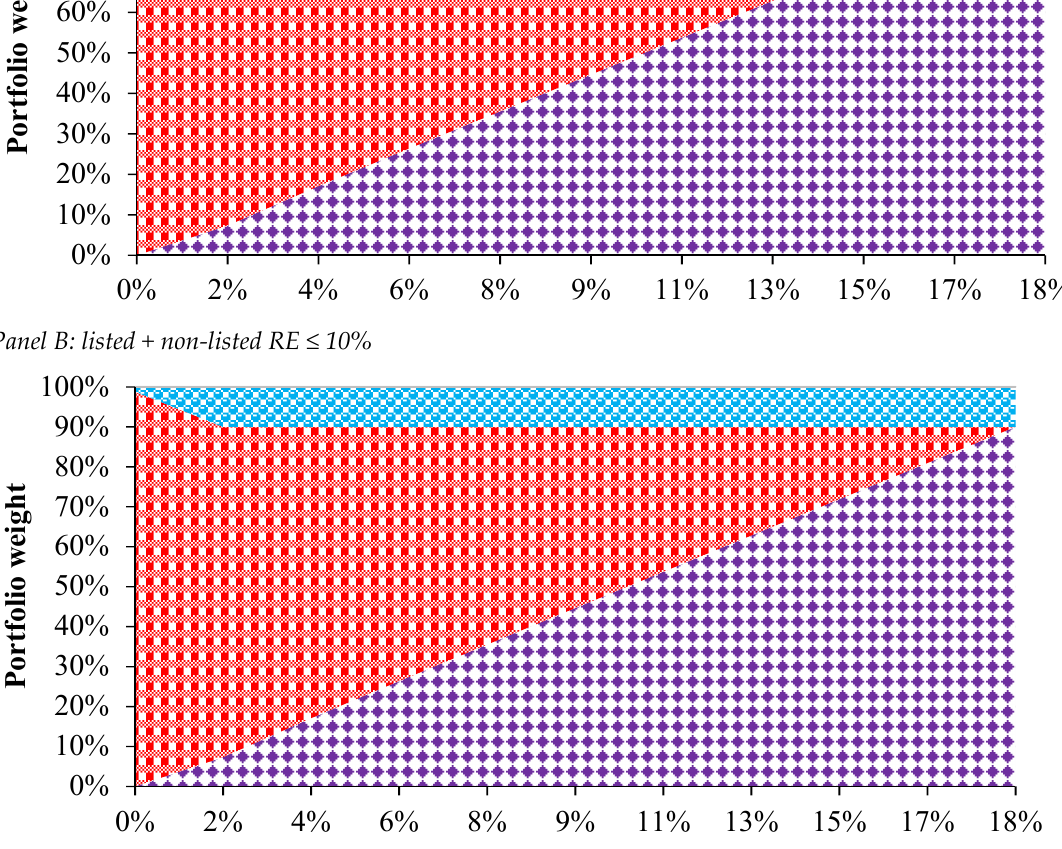
Figure 1. Japanese non-listed value-add real estate funds’ constrained asset allocation diagrams. Source: Authors’ analysis/compilation.